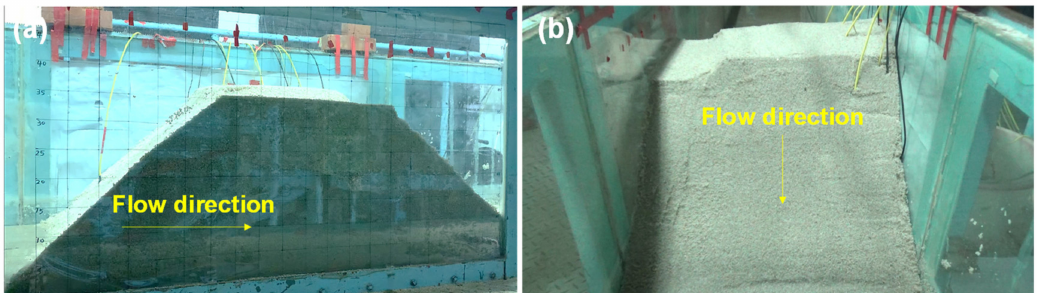
Figure 2. ( a ) The side view of the dam model and ( b ) front view of the dam